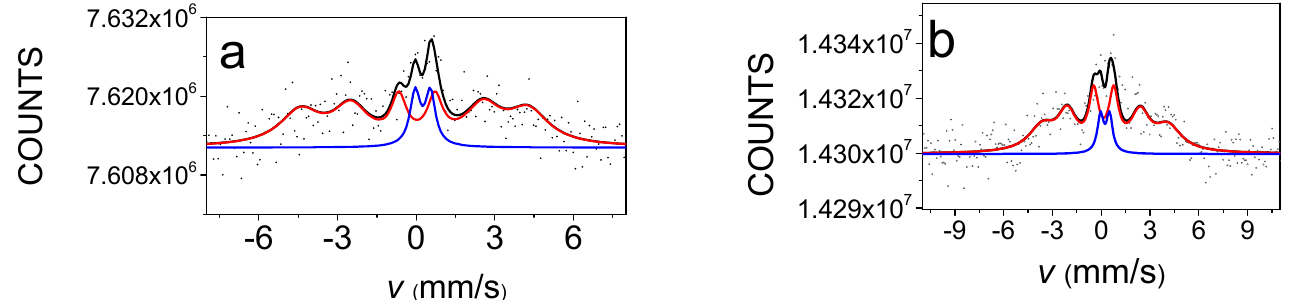
Figure 6. 57 Fe conversion electron Mössbauer spectra of DC3 ( a ) and PP3 ( b ) electrodeposited qua- ternary Sn-Fe-Ni-Co alloy coatings. The red and blue components show the ferromagnetic and par- amagnetic amorphous phases, respectively, while the black line indicates their spectral superposi- tion.